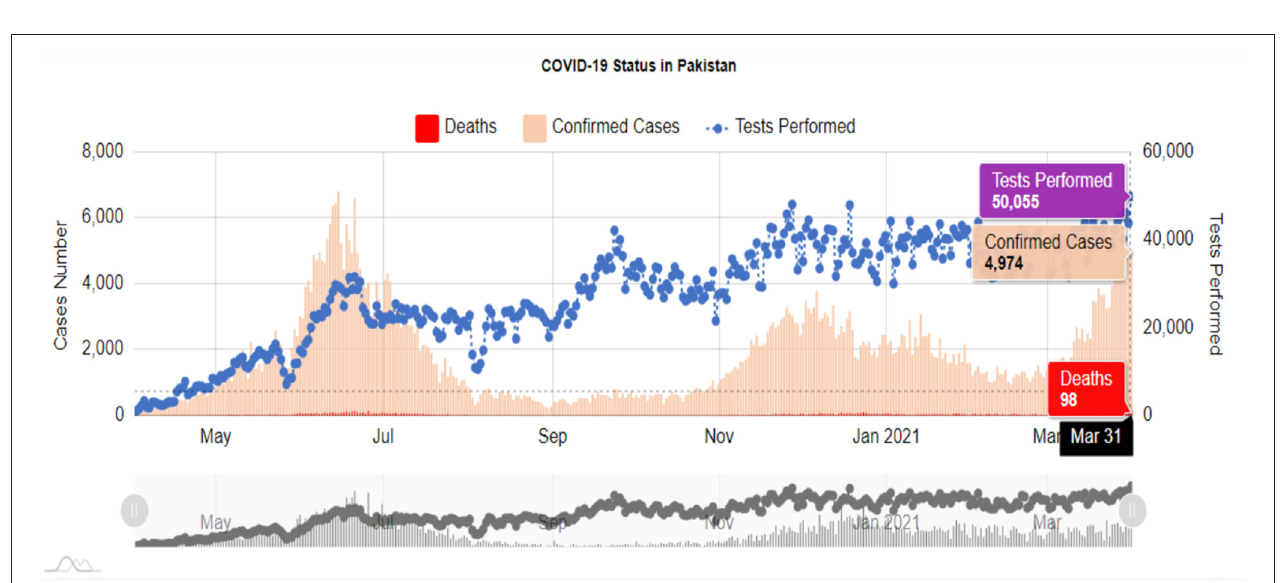
FIGURE 1 | COVID-19 status in Pakistan. The figure illustrates the deaths, confirmed cases, and tests performed from May 2020 to 31st March 2021 (The data were obtained from https://covid.gov.pk/).